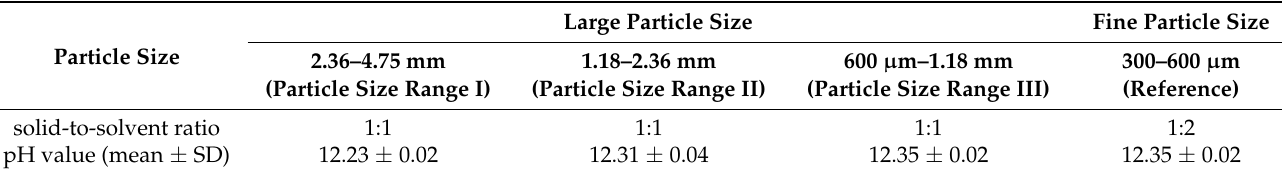
Table 4. Effect of the solid-to-solvent ratio of different large particle sizes on pH.